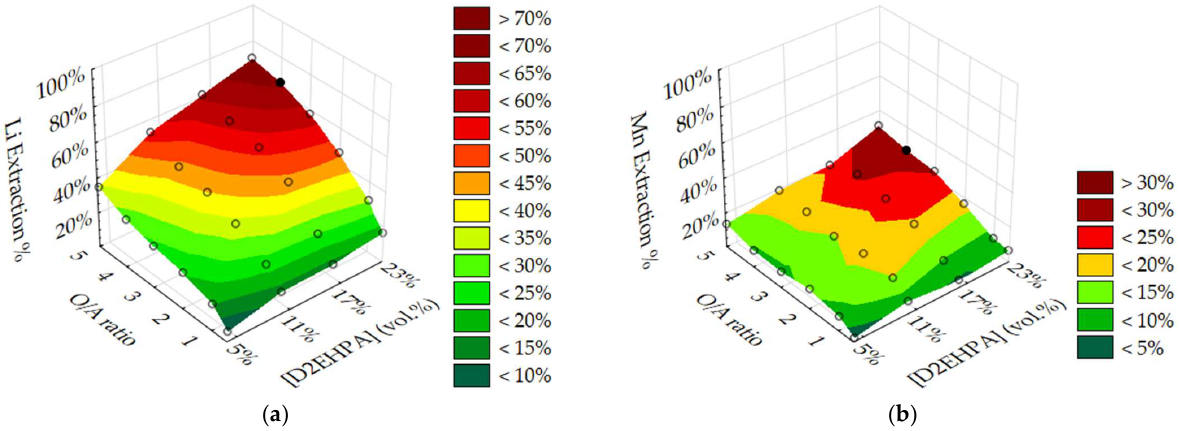
Figure 7. ( a ) Li and ( b ) Mn extractions as functions of O/A ratio and D2EHPA concentration at pH 5.5.